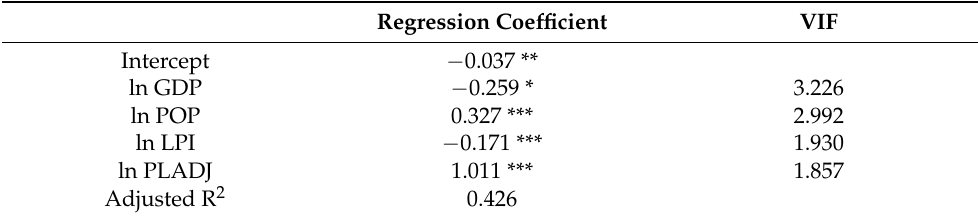
Table 2. The results of the OLS regression and the VIF values for all independent